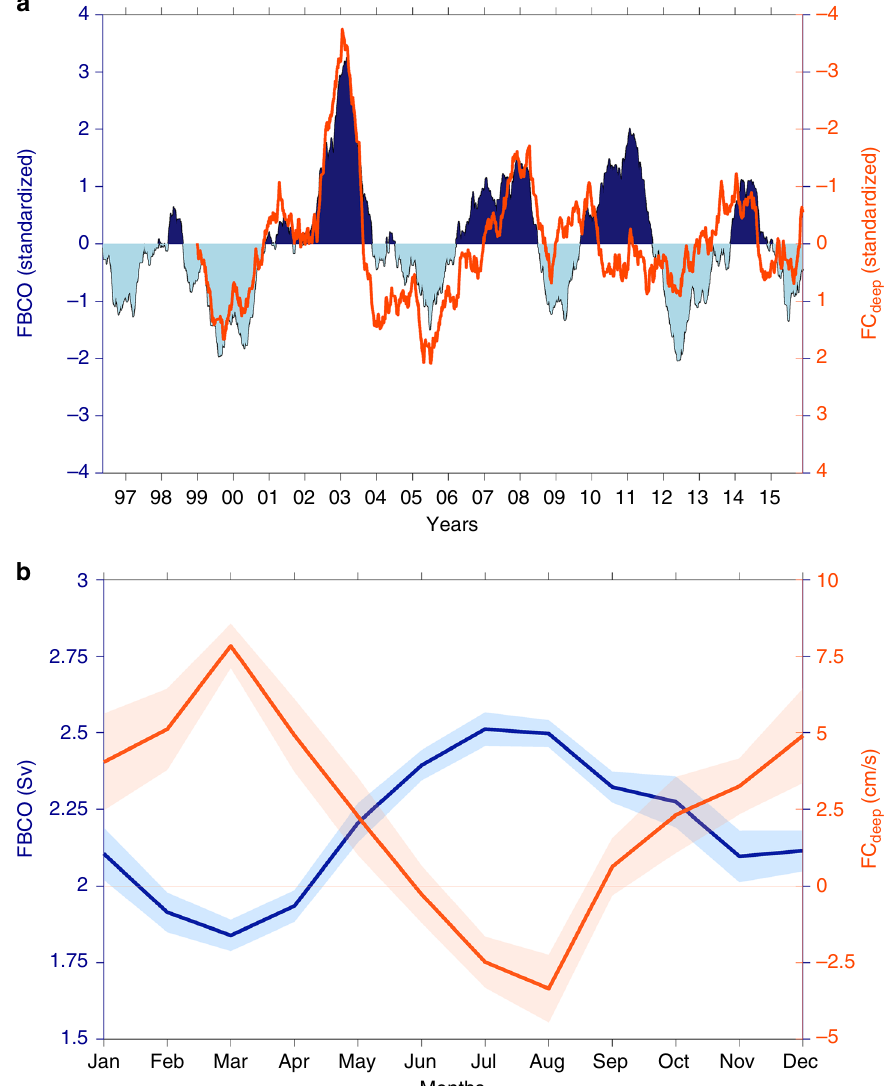
Fig. 2 Inferring the eastern over fl ow pathway. a Standardized Faroe Bank Channel over fl ow (FBCO) for the 1996 – 2016 period (shading) overlaid by the standardized Faroe Current deep (FC deep , orange line). The axis of the standardized FC deep is inverted. The time series have been detrended and smoothed with a 360-day running mean. The correlation coef fi cient between the time series is − 0.69 ( p < 0.01). The signi fi cance at the 99% con fi dence level is according to a random phase test 35 using 20000 Monte Carlo simulations. b Seasonal cycle of the FBCO (blue; Sv) and FC deep (red; cm s − 1 ). Positive transport of the FBCO means southwards into the North Atlantic Ocean. Positive/negative velocities of the FC deep mean eastwards/westwards. The shading denotes the standard error of the